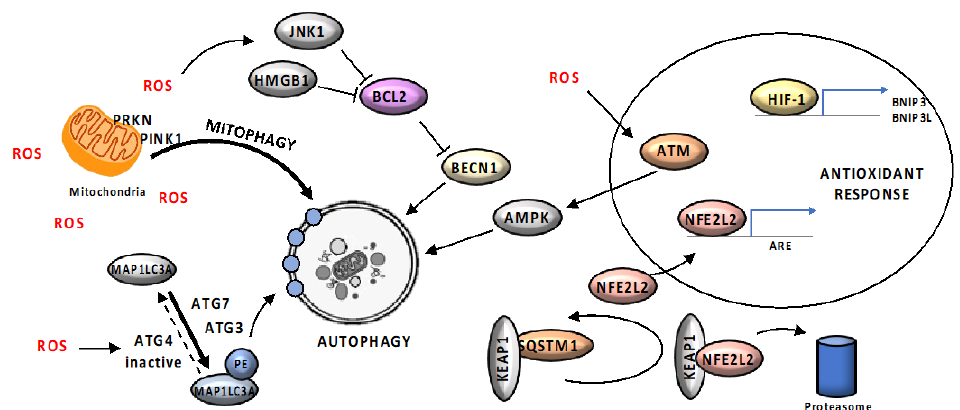
Figure 5. Schematic representation of main pathways linking oxidative stress to autophagy. Mitochondria, the main source of cellular ROS; in order to limit ROS damage, autophagy clears damaged and dysfunctional mitochondria by mitophagy. ROS-mediated ATG4 oxidation causes MAP1LC3A-II accumulation, promoting its association with the autophagosome membrane. Accumulation of ROS activates autophagy by inhibiting mTORC1 activity via the ATM/STK11/AMPK axis. ROS promote HMGB1 (high mobility group box 1) translocation from the nucleus to the cytosol, where it induces autophagy disrupting the inhibitory interaction of BCL2 with BECN1. In response to oxidative stress, JNK1 (c-Jun-N-terminal kinase 1) becomes activated and in turn induces autophagy by phosphorylating BCL2, thereby disrupting the BCL2/BECN1 interaction. SQSTM1 directly interacts and sequesters KEAP1 into autophagosomes, disrupting the KEAP1-mediated NFE2L2 (nuclear factor, erythroid 2 like 2) ubiquitination and leading to NFE2L2 release into the nucleus and thereby activation of specific transcription program. During ROS-induces Hypoxia, HIF-1 (Hypoxia-inducible factor 1) activate the expression of autophagy key proteins, including mitophagy receptors BNIP3 and BNIP3L, to mitigate hypoxic condition and mitochondrial ROS generation. Black arrows ( ↑ ) and perpendicular lines ( ) indicate activation and repression, respectively. Blue arrows indicate transcriptional regulation. ⊥